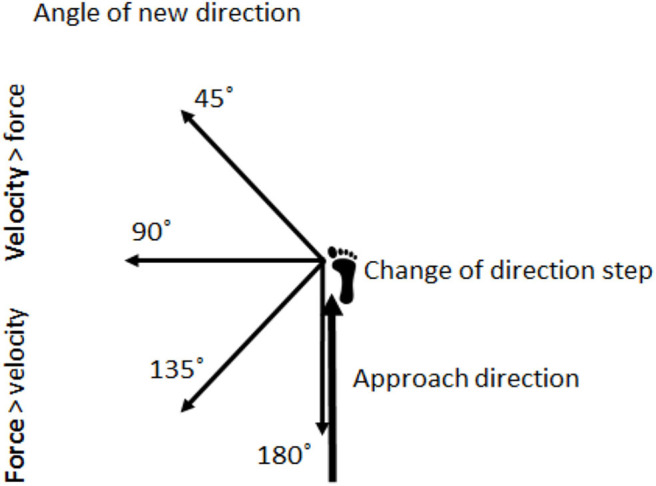
Illustration of how the entering speed in the approach direction and angles of the plant step make the COD velocity-dominant or force-dominant. The figure is adapted from Bourgeois et al. (2017).